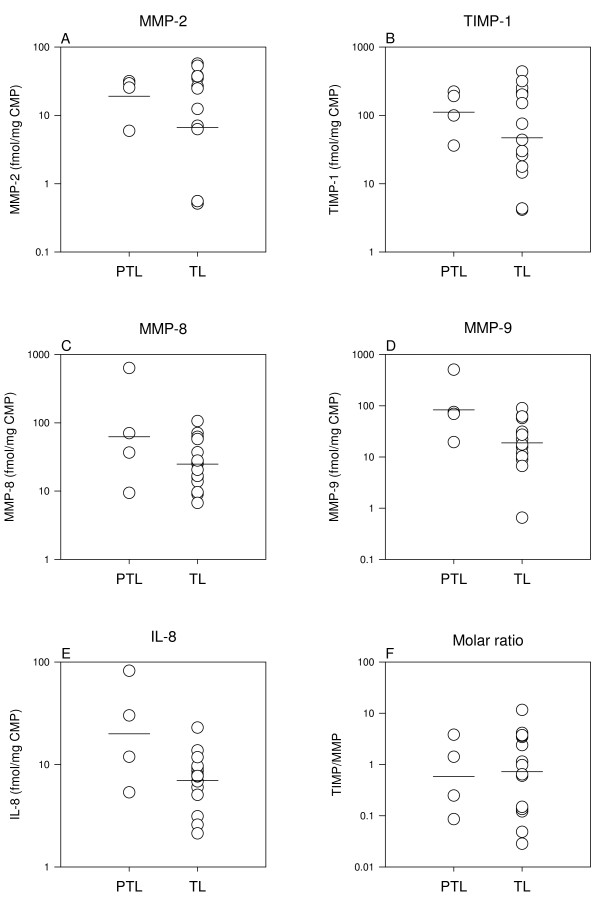
Preterm and term labor. Comparison of concentrations and the molar TIMP/MMP ratios in preterm (PTL, n = 4) and term (TL, n = 15) whole CMPs. Results from Students t-test are listed in Table 4. Note the log-scale.